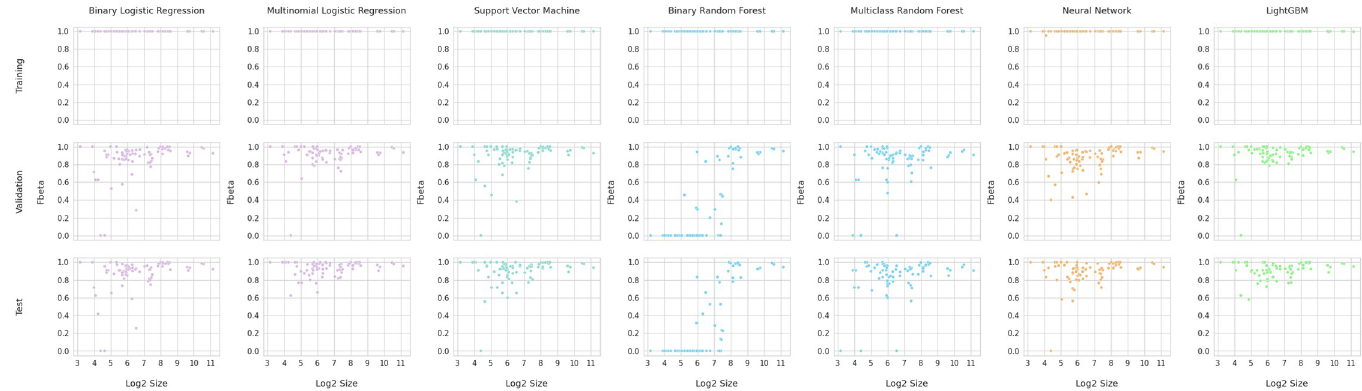
Fig 4. Model performance on training, validation, and test datasets. CV thresholds of 2.5 were used for Multinomial Logistic Regression and Neural Networks while a threshold of 3.5 was used for all other models. F-beta was calculated as a measure of classification accuracy for the training, validation, and test datasets. Log2 size is log base 2 of the cluster size. Differences between these distributions highlight the effect of overfitting.